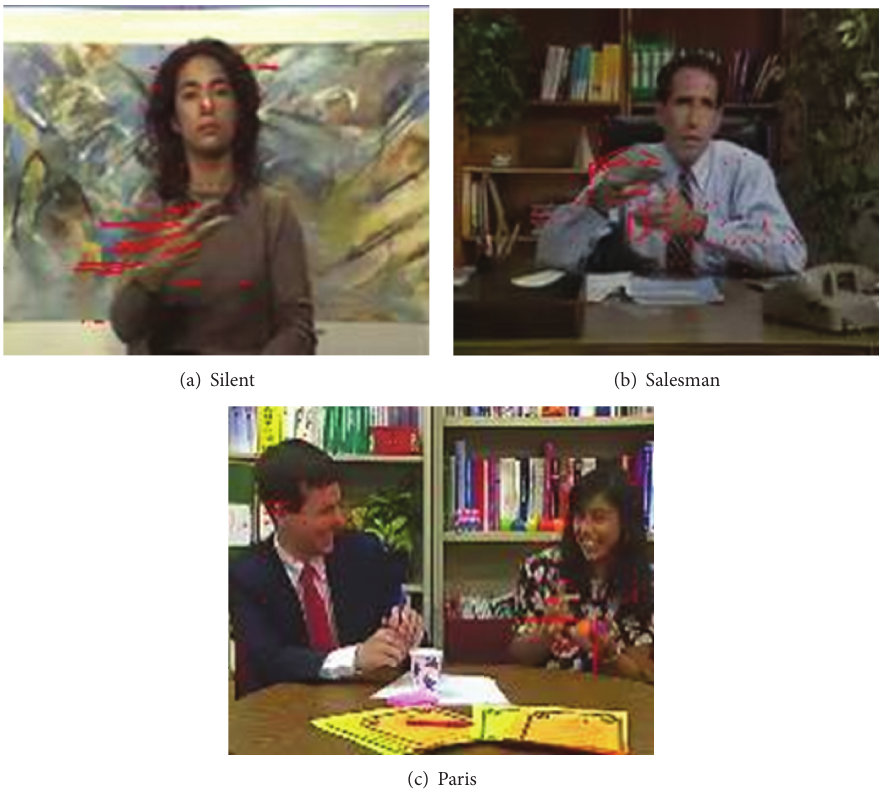
Figure 3: MV distribution in static background video frames.